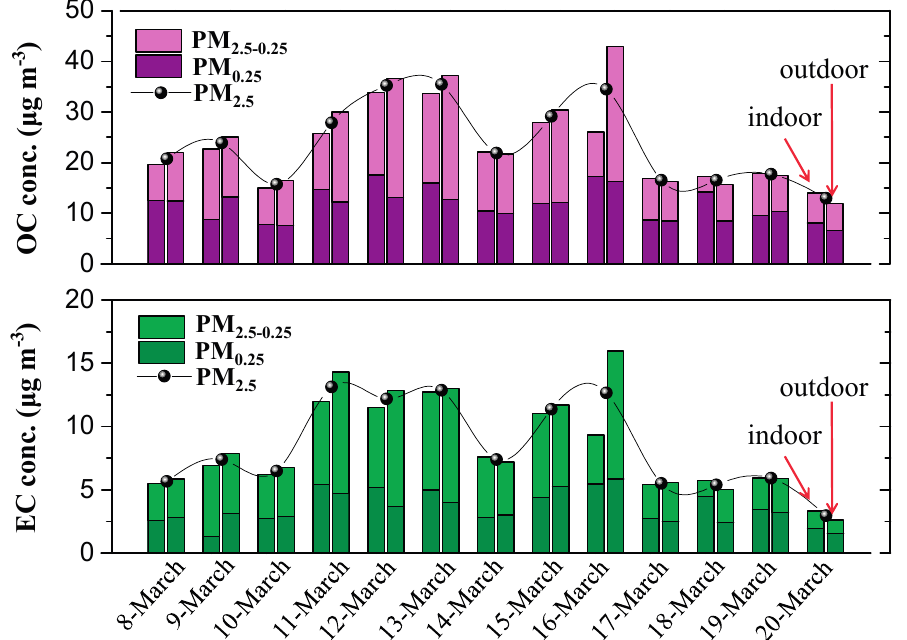
Figure 1. Time variations of OC and EC concentrations in PM 2.5 and PM 0.25 inside the classroom (left one of a couple of bars) and outdoors (right one of a couple of bars) in Xi’an,